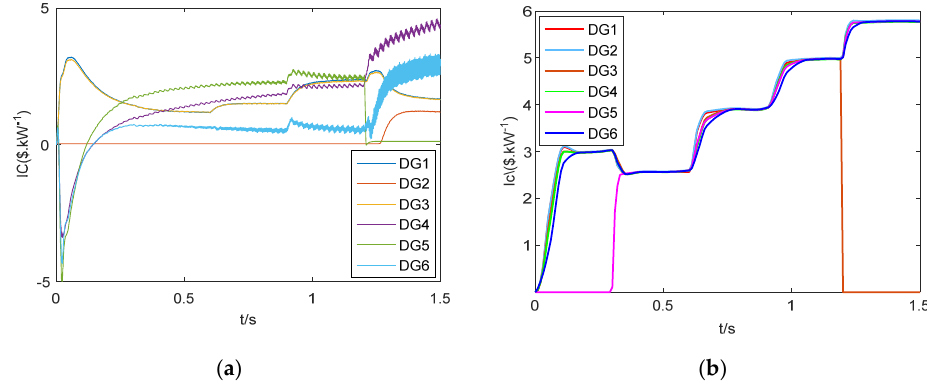
Figure 11. Distribution diagram of incremental cost of each distributed generation. ( a ) Cost increment of distributed nodes in hybrid microgrid under traditional droop control. ( b ) Cost micro increment of distributed nodes in hybrid microgrid based on OPPRA.